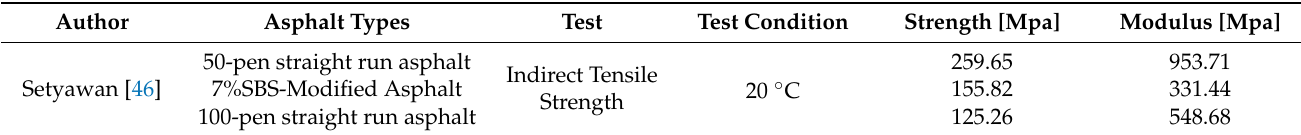
Table 6. Optimal binder and low temperature performance of